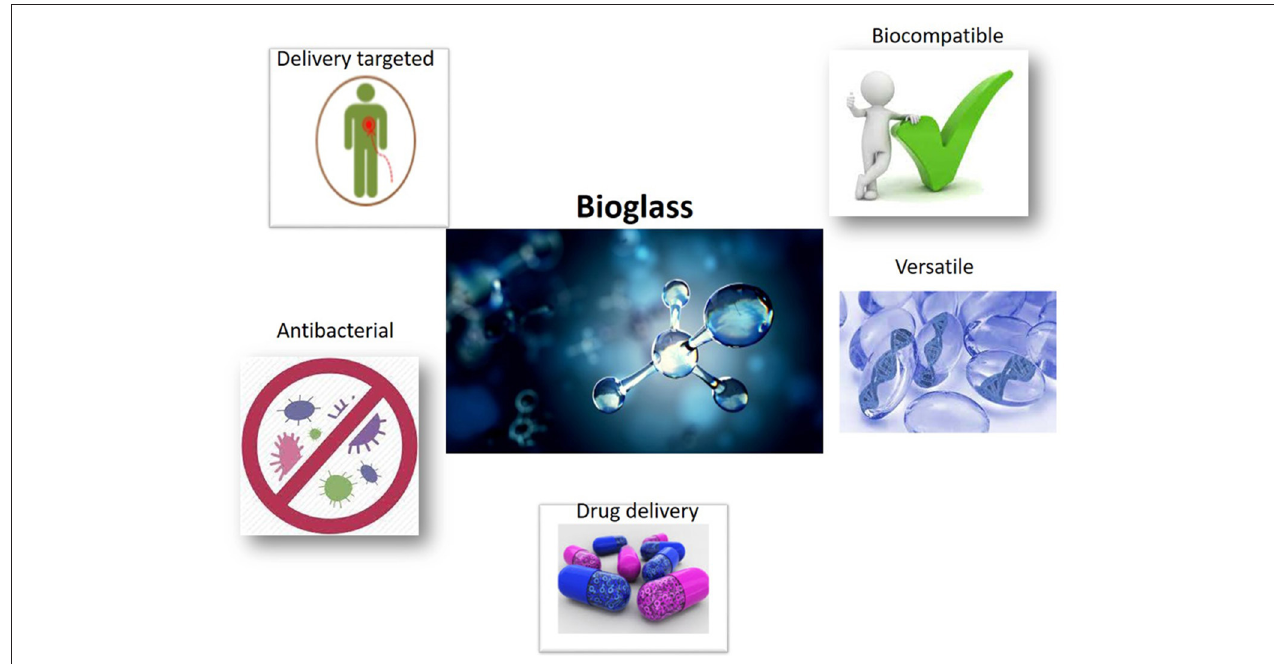
FIGURE 2 | Properties of bioactive glasses BGs as scaffolds employing in regenerative medicine. The principal proprieties of BGs are an optimal drug delivery, antibacterial and biocompatible proprieties, and versatile